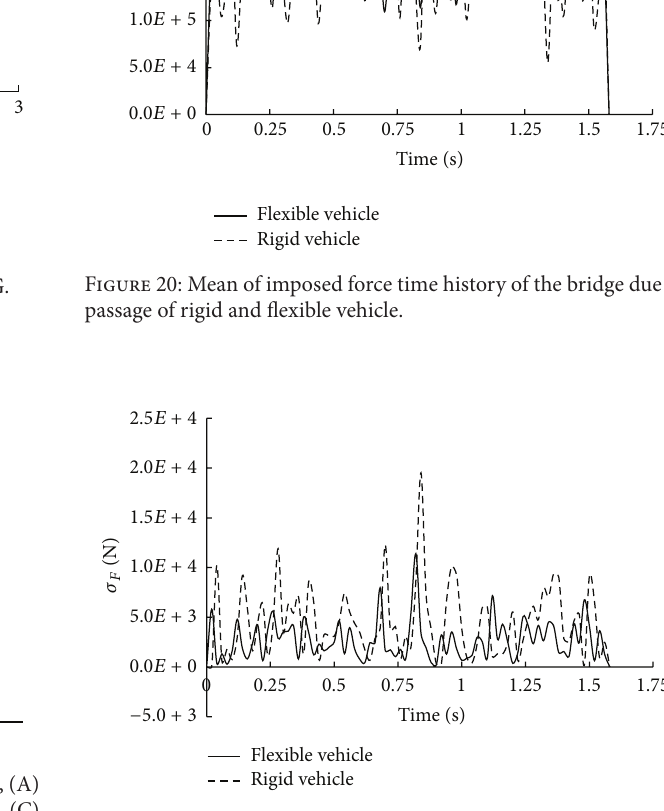
Figure 21: Standard deviation of imposed force time history of the bridge due to passage of rigid and flexible